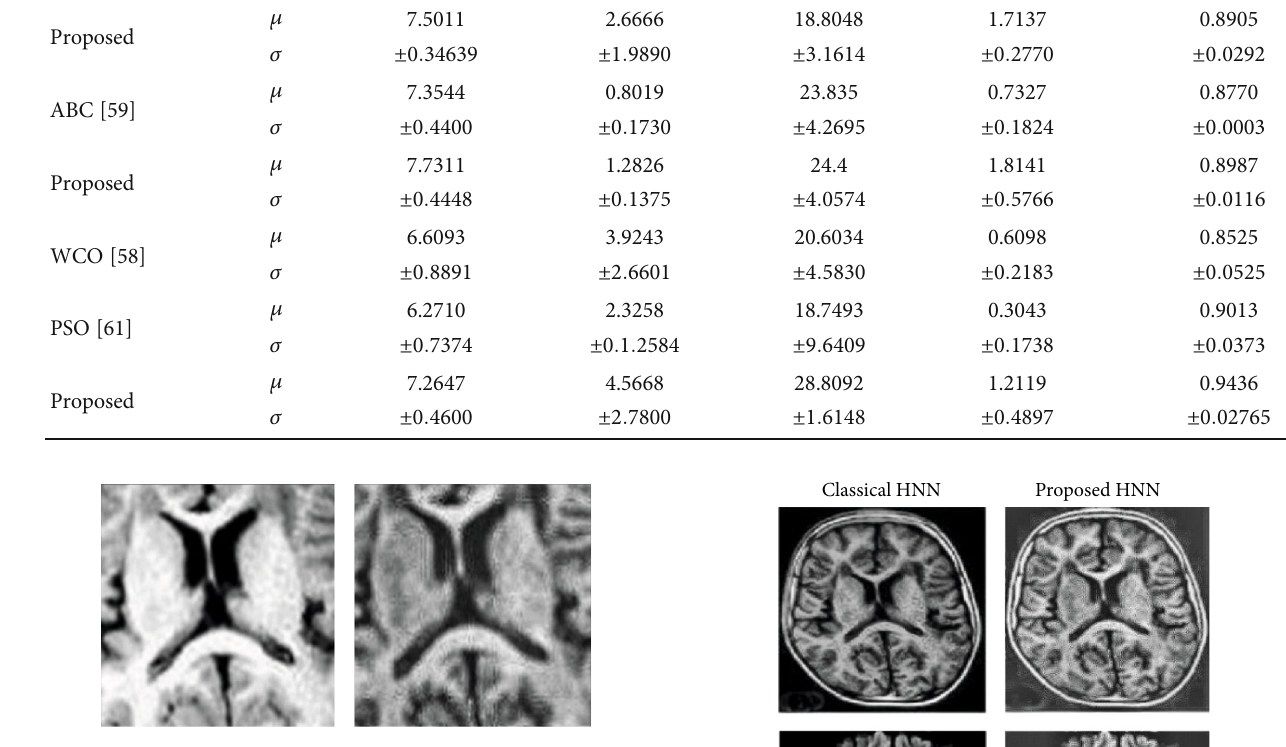
Figure 6: Sample of the zoomed sections comparing proposed method with existing methods.